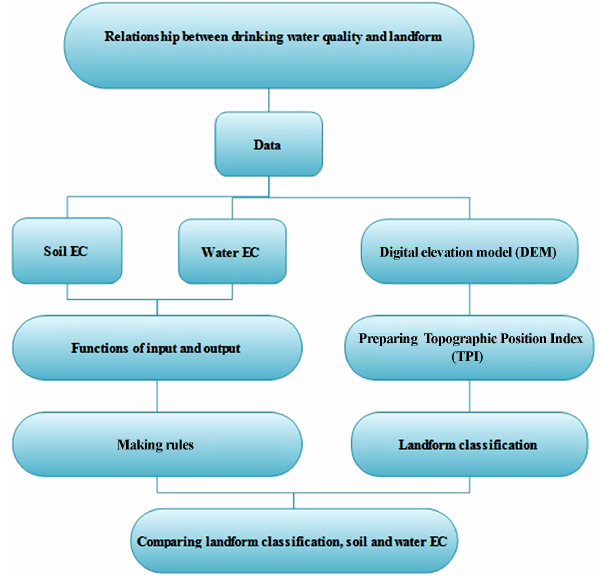
Figure 1. Flowchart of the methodology employed to investigate the relationship between landform classification, and soil and water